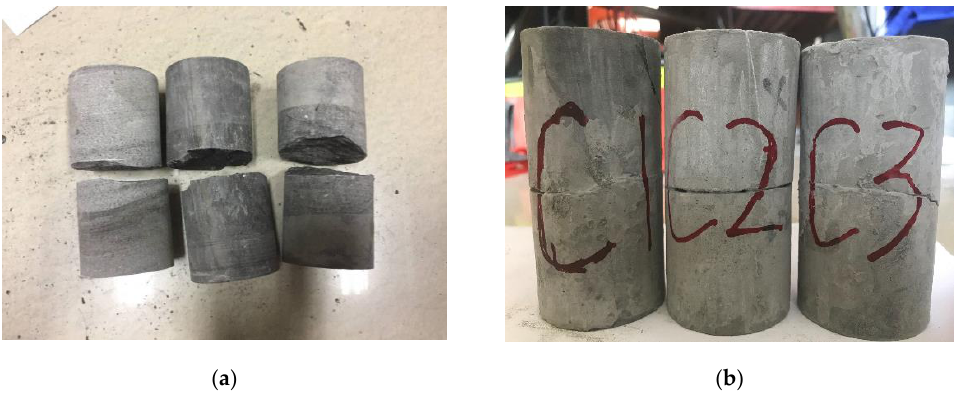
Figure 1. Tensile grouting rock fractures: ( a ) normal splitting of specimens and ( b ) grouting reinforcement of specimens.